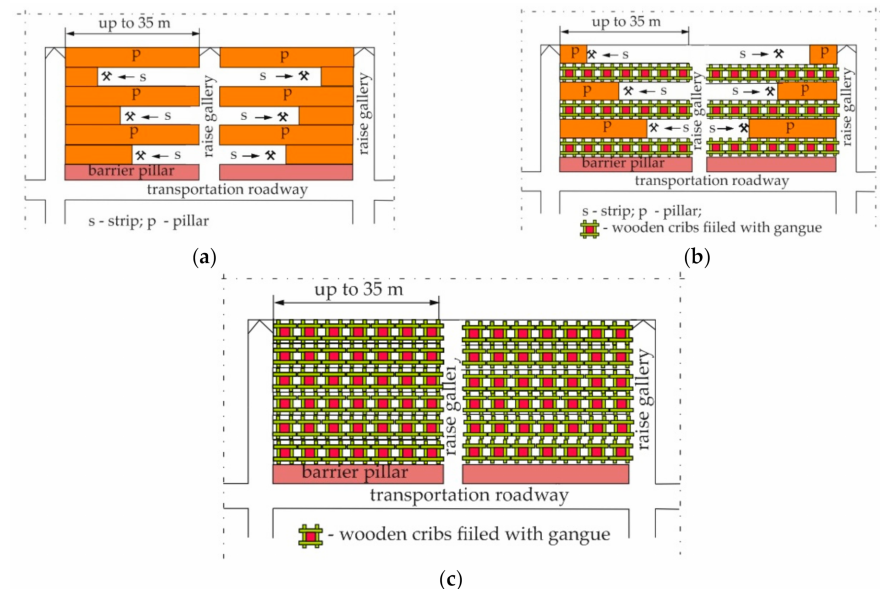
Figure 11. Strip mining method with the three stages of exploitation in relation to the management of wooden cribs filled with gangue: ( a ) First stage; ( b ) Second stage; ( c ) Third